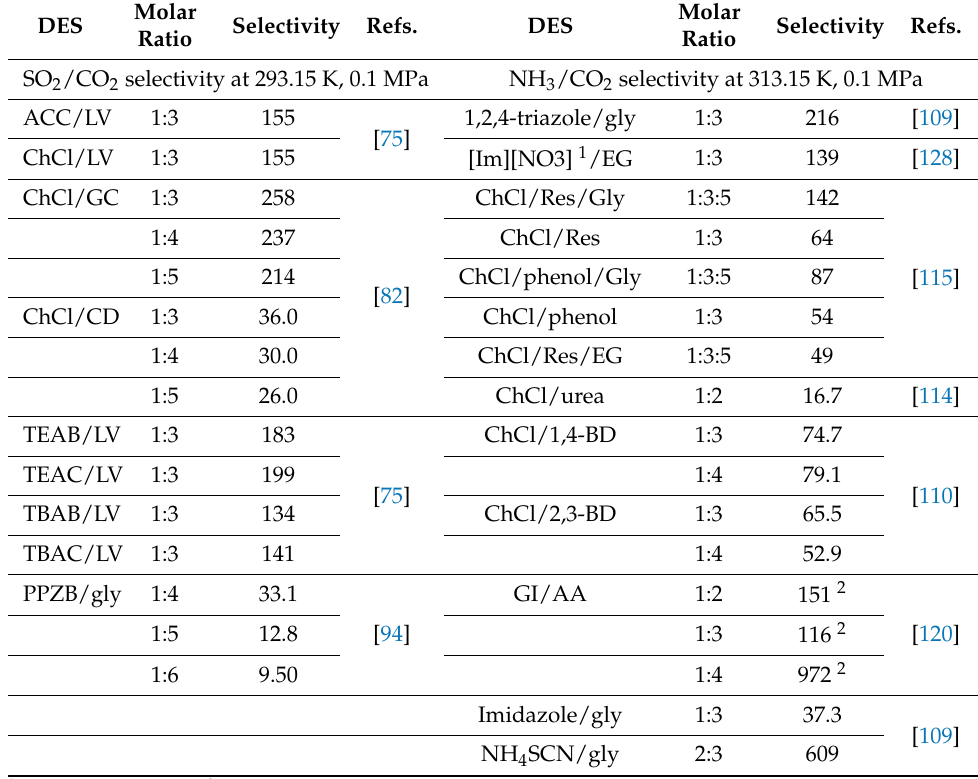
Table 4. Selectivity data of SO 2 /CO 2 and NH 3 /CO 2 using DESs. Molar DES